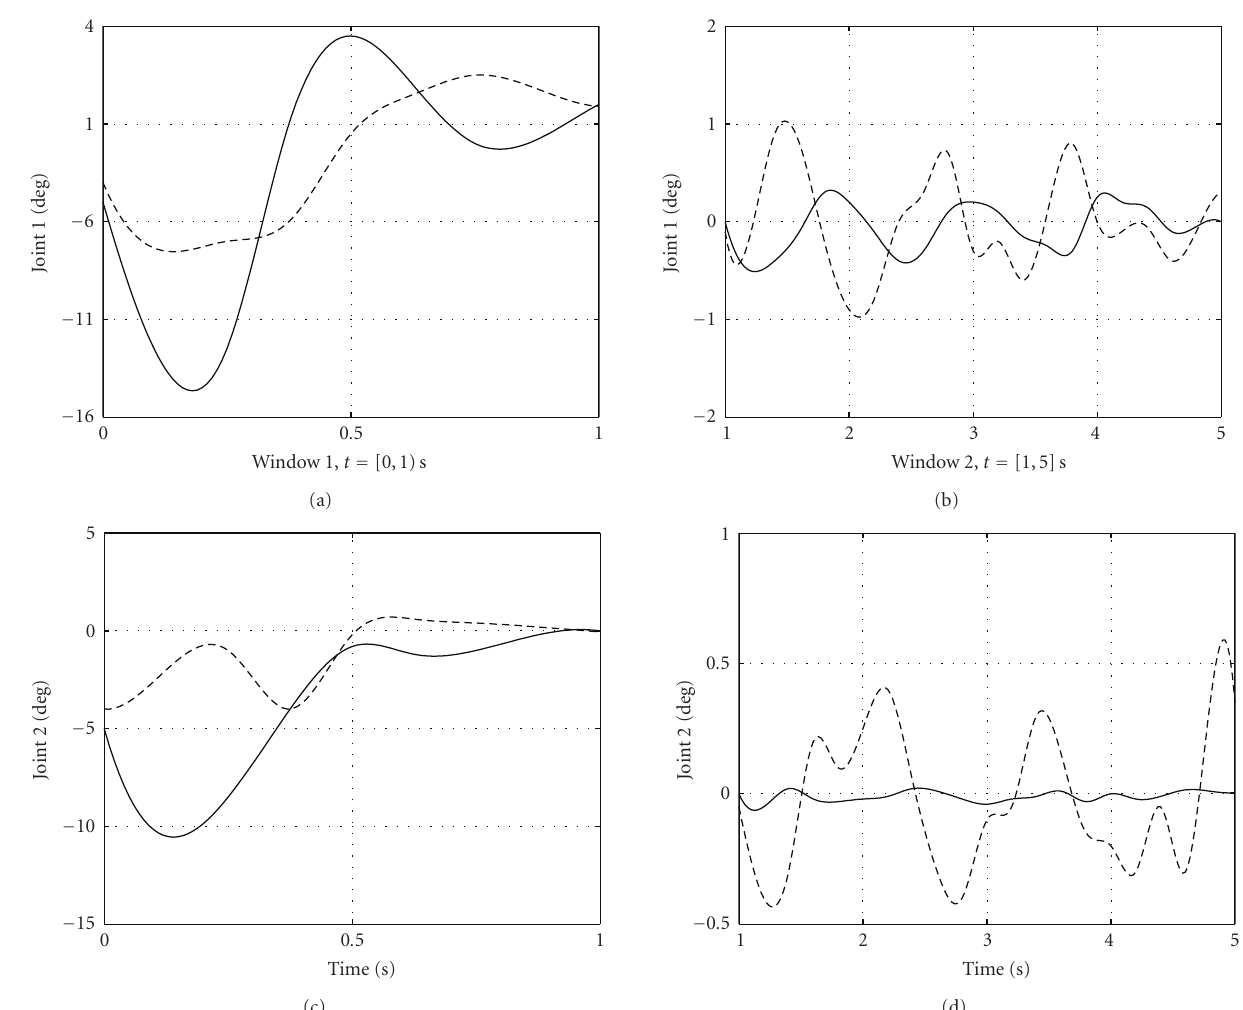
Figure 9: Comparative plots for tracking errors of both joints between the controller [14] (.–) and our proposed controller (–).